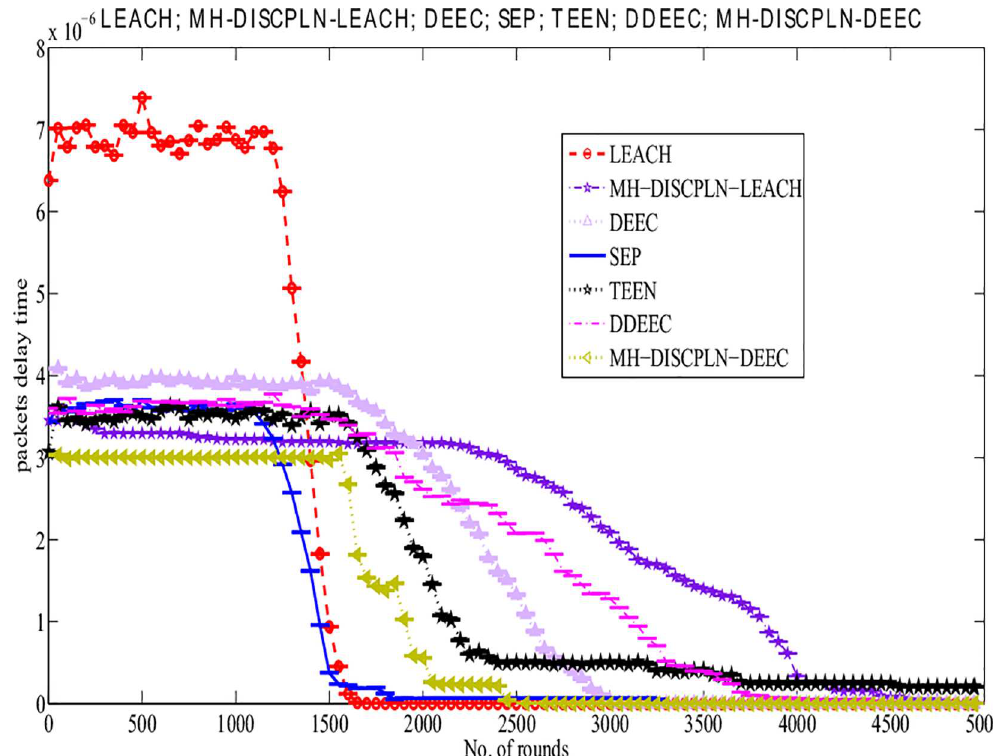
Fig 14. Performance comparison basedon packet delay for multi-hop